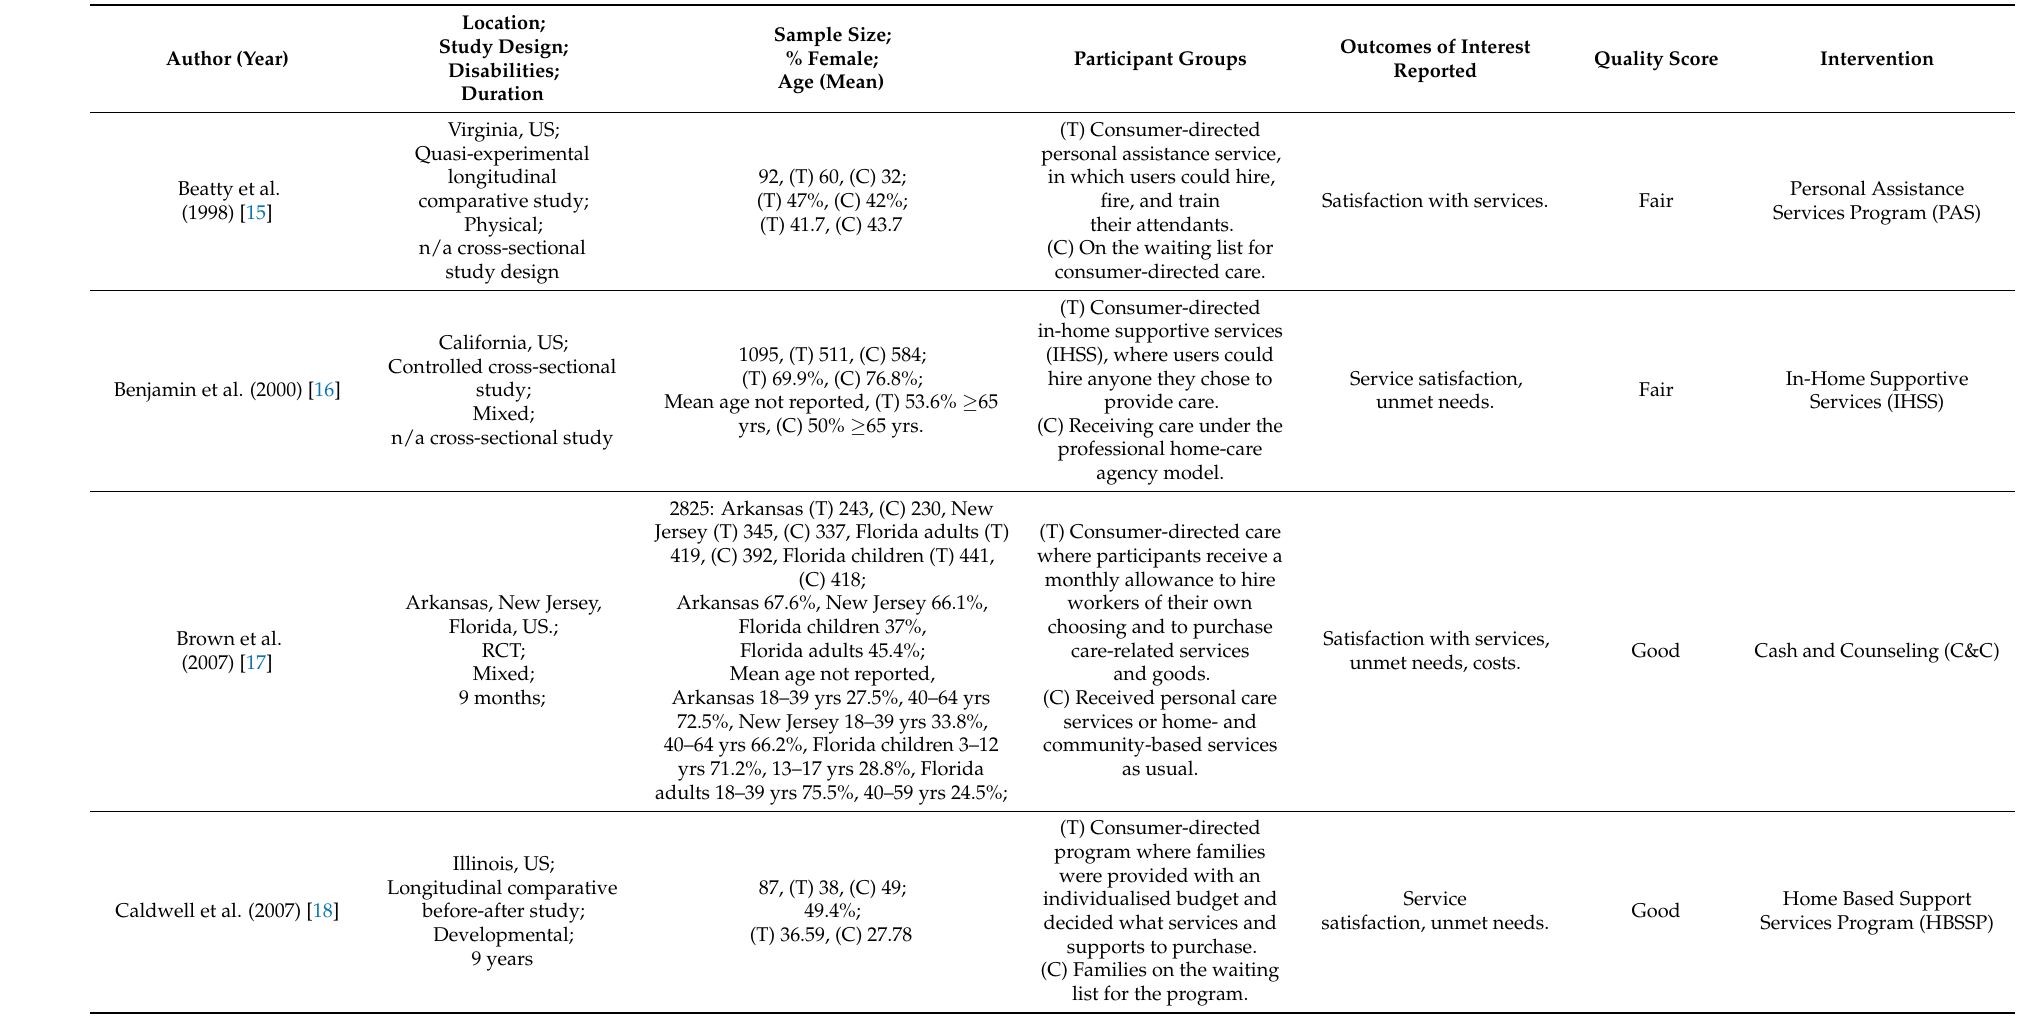
Table 2. Article characteristics for service user and caregiver